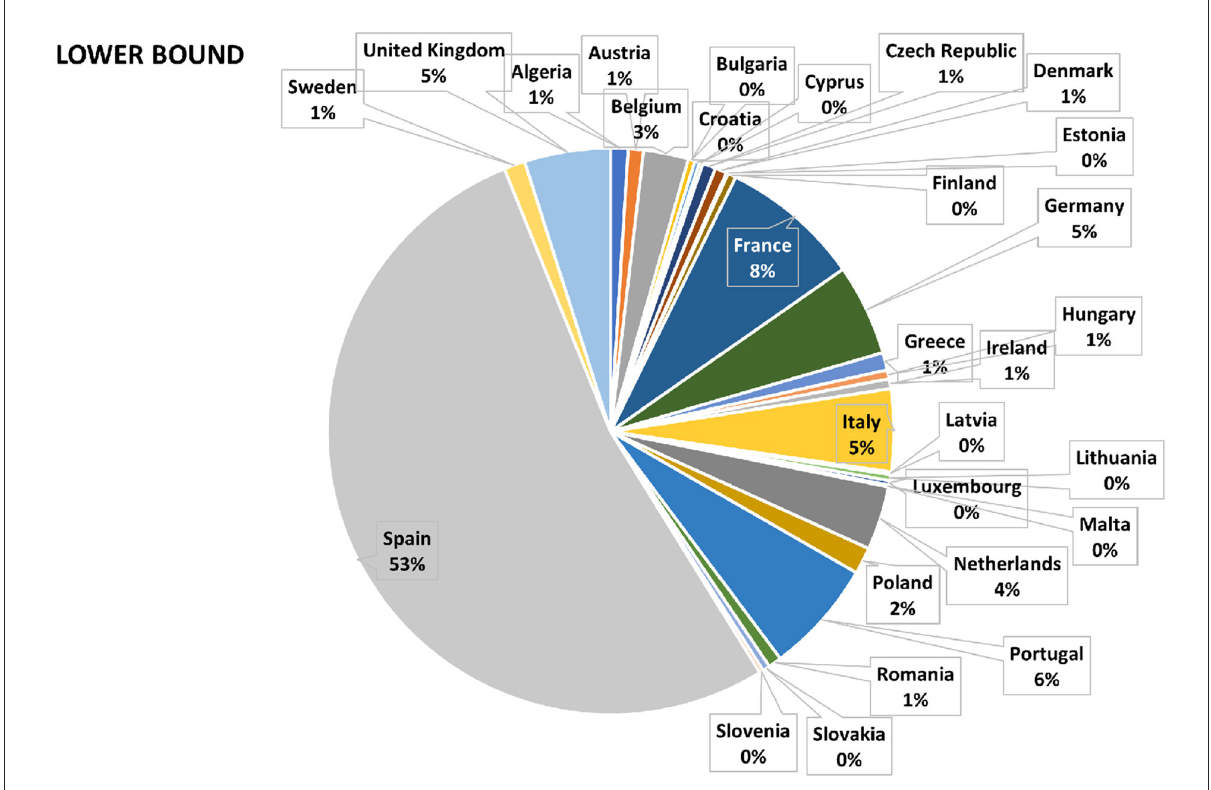
FIGURE8 Percentages of lower bound losses for 3 days of delay caused by a cyber-physical